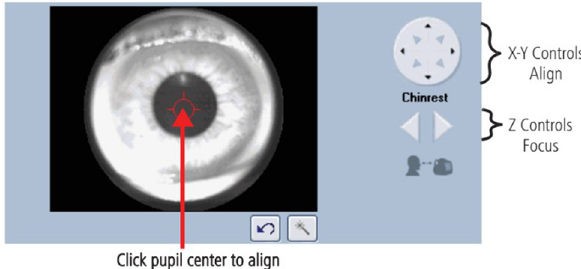
Figure 1: Position control of the OCT scanning beam for the Cirrus HD - OCT machine ( Carl Zeiss Meditec, Inc., Dublin, CA ) . The X – Y panel controls the horizontal and vertical movement of the screening center ( red circle ) . The Z panel controls the